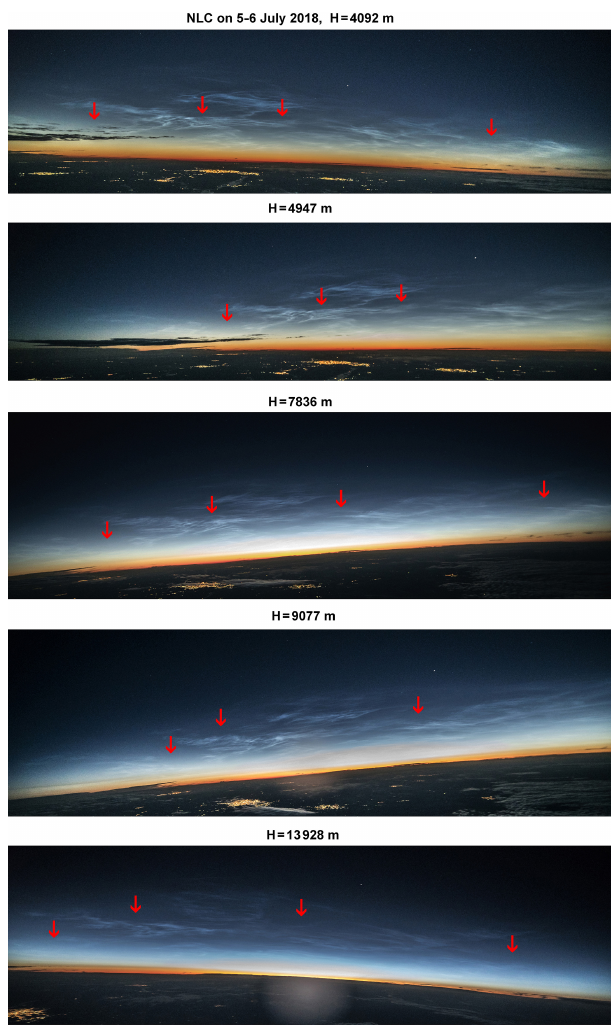
Figure 4. The NLC field as observed from the SONC balloon at 4092, 4947, 7836, 9077, and 13928m above the ground at 21:46, 21:49, 21:57, 22:01, and 22:20UT on 5 July 2018. The red arrows indicate the centres of large areas free from NLC particles (partial ice voids).